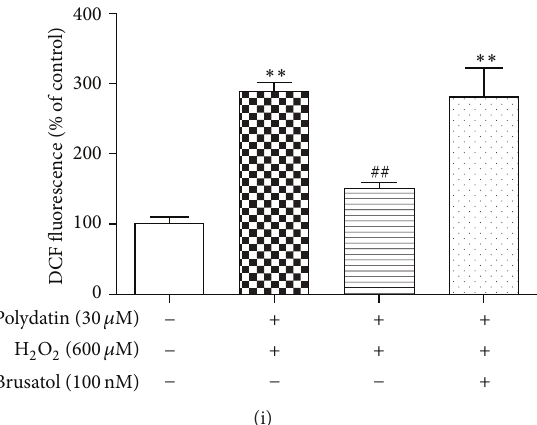
Figure 6: Polydatin protected BMSCs against H 2 O 2 -induced cell death partly through Nrf 2/ARE pathway. BMSCs were pretreated with polydatin for 2h and further exposed to H 2 O 2 for 12h. (a) Effects of polydatin on NQO-1 and the phosphorylation of Nrf 2. (b, c) Quantitative analysis of the blots was shown in panel after being normalized by 𝛼 -tubulin. (d) Cells were treated with different concentration of brusatol for 24 h. Effects of brusatol on phosphorylation of Nrf 2 were detected by Western blot and (g) the bands were normalized by 𝛼 -tubulin. (e) Cell viability was tested in the presence of different concentration of brusatol. (h) BMSCs were pretreated with brusatol (100 𝜇 M) for 1 h followed by incubating with/without polydatin and H 2 O 2 for 24 h. (f) ROS production was detected by H2DCF-DA staining. (b) Quantitative analysis of DCF fluorescent intensity. One-way ANOVA followed by Tukey’s test. ∗ 𝑝 < 0.05 and ∗∗ 𝑝 < 0.001 versus control group; # 𝑝 < 0.05 and ## 𝑝 < 0.01 versus H 2 O 2 -treated